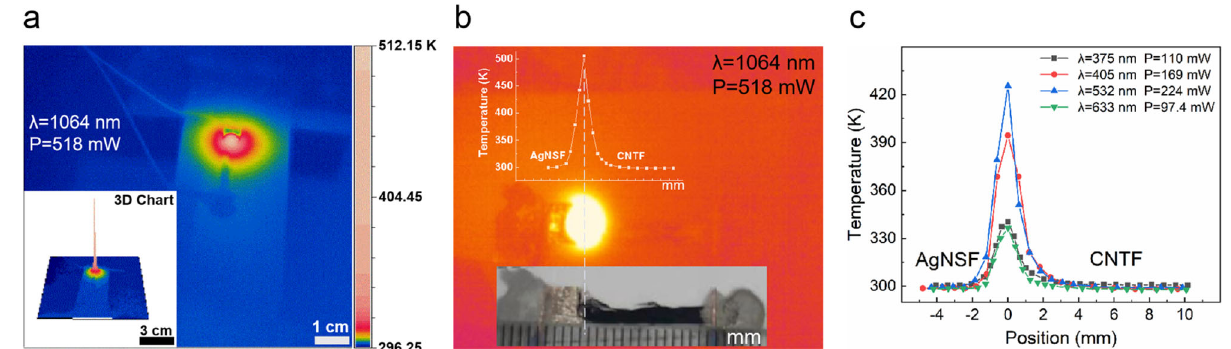
Fig. 1 Local large Δ T . a Heatmap obtained when the heterojunction of the sample was irradiated by a laser with wavelength of 1064 nm and power of 518 mW. The inset shows a three-dimensional image of the heat distribution. b The infrared photograph of the actual sample. Upper inset is temperature – position curve, in which the location with the highest temperature is the center of the heterojunction; lower inset is a photograph of the actual sample. c Temperature – position curves of the AgNSF/CNTF heterojunction irradiated by lasers with wavelengths of 375, 405, 532, and 633 nm, where the position of 0 mm is the center of the